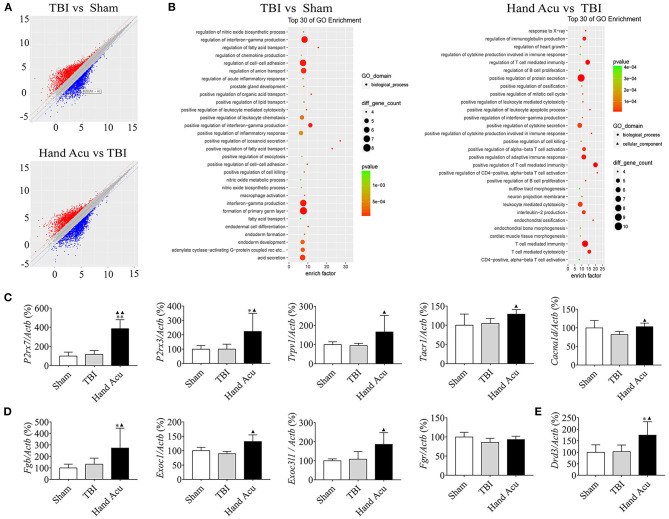
HTWP acupuncture activates the pathways of neural projection and protein secretion in the brainstem. (A) Differential gene scatter plots (red and blue plots represent up- and downregulated genes, respectively). (B) Top 30 of GO enrichment analysis. The larger dots represent higher number of genes. The following genes were analyzed (n = 5/group; one-way ANOVA). (C–E) Quantitative analysis of the gene expression of factors related to (C) neural projections: P2rx7, P2rx3, Trpv1, Tacr1, and Cacna1d or (D) protein secretion: Exoc1, Exoc3l1, Fgb, Fgr, and (E)
Drd3. Error bars represent mean + SEM; *P < 0.05, **P < 0.01 vs. Sham; ▴P < 0.05, ▴▴P < 0.01 vs. TBI.